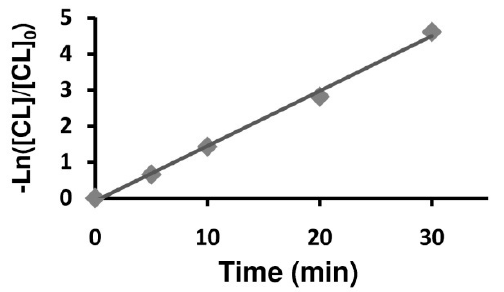
Figure 4. Plots of -Ln([CL]/[CL] 0 ) vs. time in the ROP of ε -CL initiated by Al2 /BnOH (runs 3 and 7–9, Table 1).